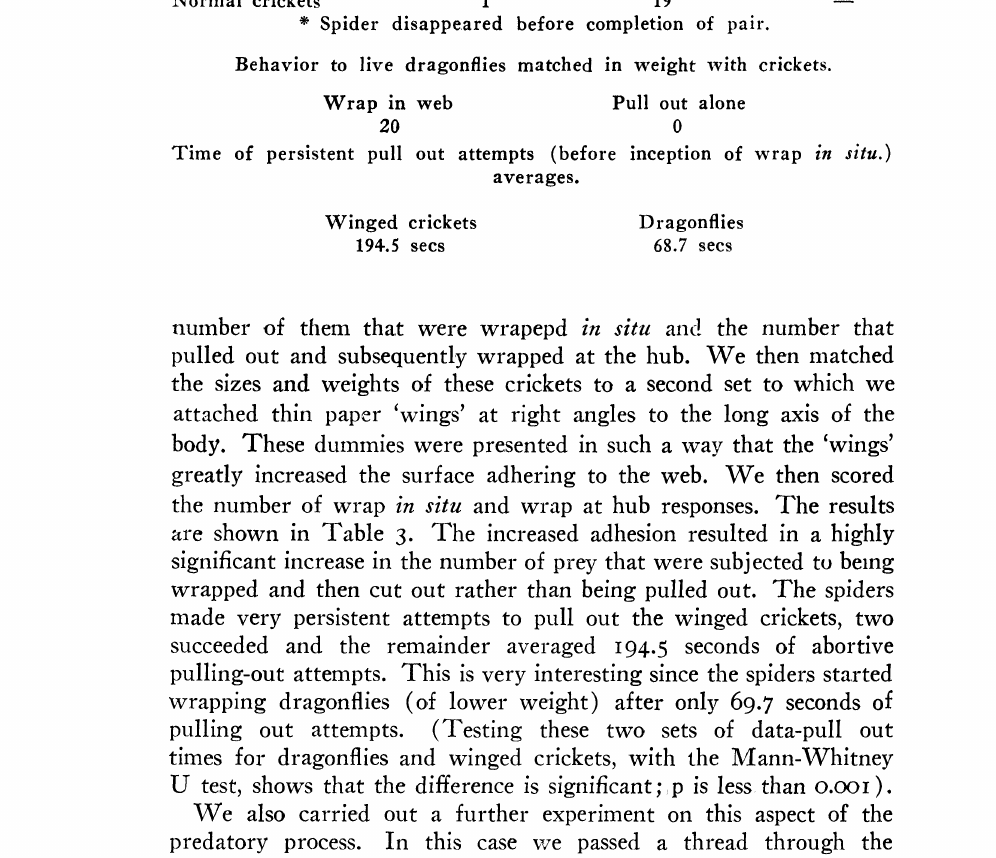
Table 3. VVrap in situ behavior (i). Experiment with ’winged’ and normal crickets. Wrap in web Pull out alone Winged crickets 18 Normal crickets 19 * Spider disappeared before completion of pair. Behavior to live dragonflies matched in weight with crickets. Wrap in web Pull out alone 20 0 Time of persistent pull out attempts (before inception of wrap in situ.)